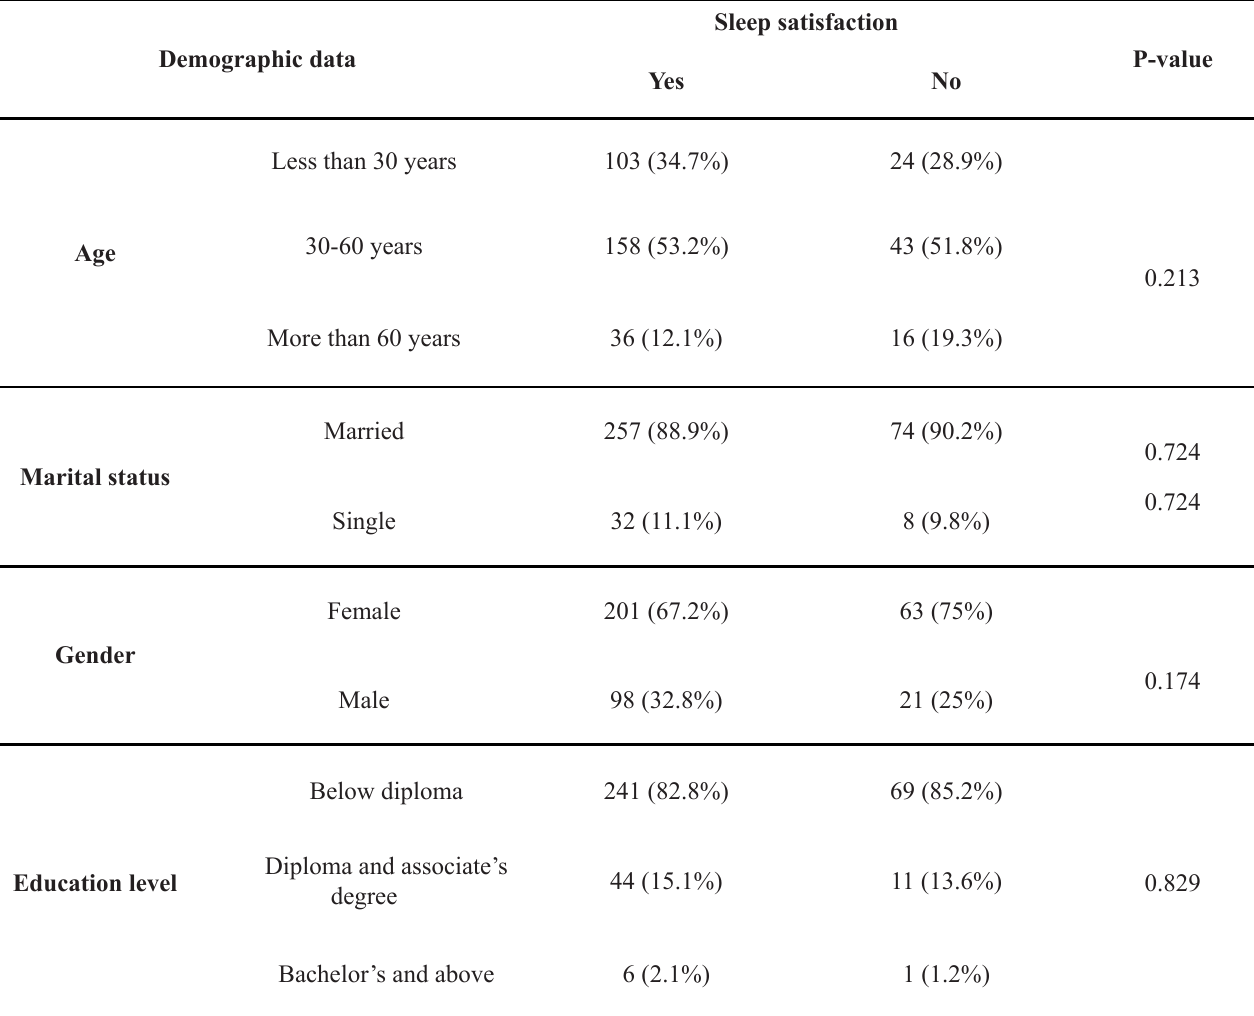
Table 2. The assosiation between sleep satisfaction and demographic